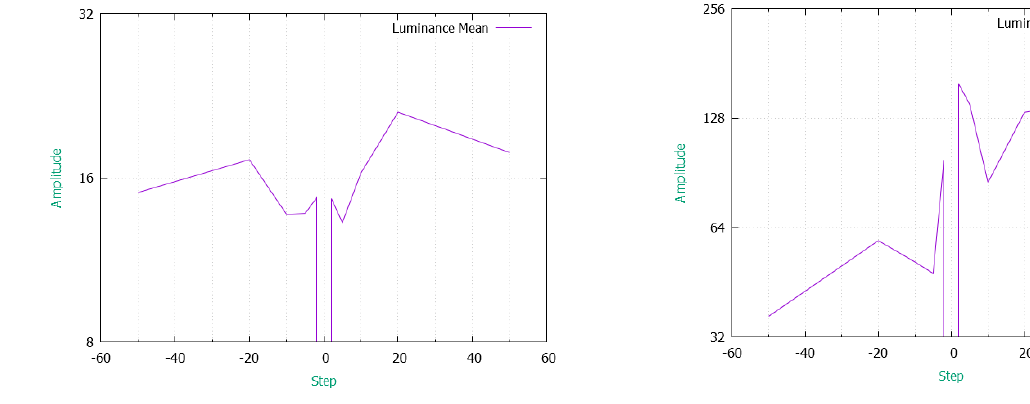
Figure 10. Plot luminance mean 64x64 px